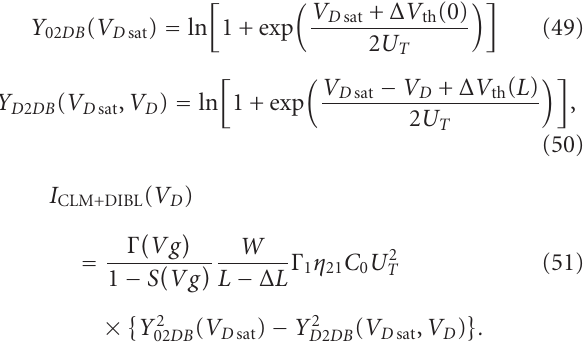
Figure 15: The total current I CLM+DIBL ( V D ) ( − ) from (51). ( L = 90nm, L/l = 9 . 5, and W/L = 10).